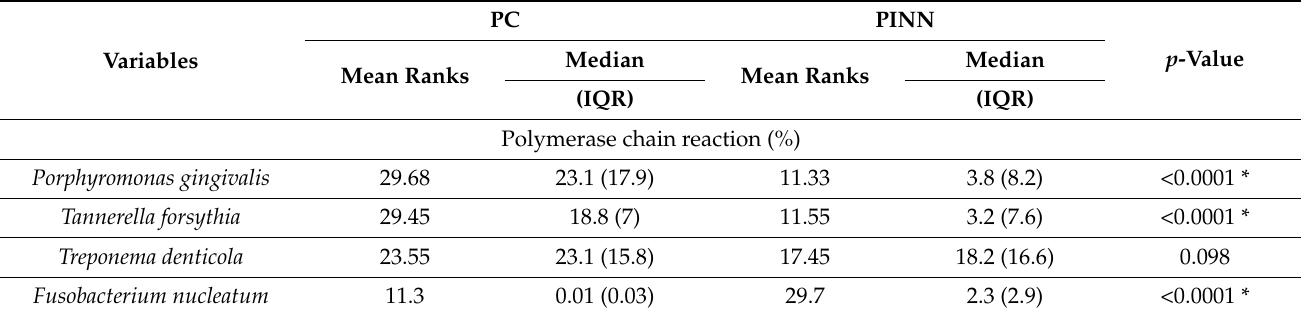
Table 4. Comparison of mean ranks of outcome variables between the periodontitis groups.